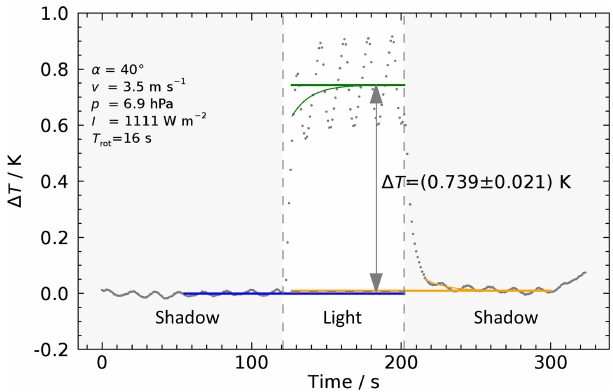
Figure 11. Example for the response of the RS41 temperature sen- sor to irradiation (dotted grey line) after subtraction of the back- ground temperature. Blue line: T mean in the shadow period ap- proximately 1min prior to light exposure. Green curve: fit to the T response according to Eq. (4). Straight green line: expected equi- librium value of the T response ( = c 0 ). Orange curve: similar fit to the T response after closing the shutter, with the straight orange line indicating the re-established shadow temperature level. The oscillat- ing pattern result from the continuous rotation of the sonde with a period of